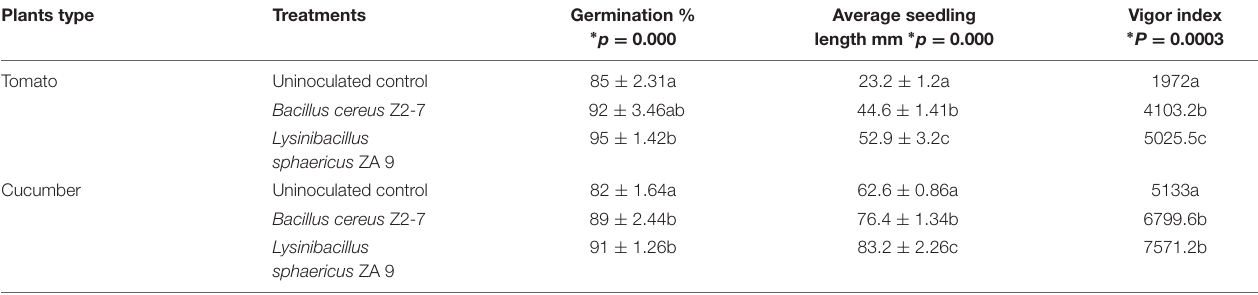
TABLE 1B | Effect of L. sphaericus ZA9 on germination percentage and seedling vigor of tomato and cucumber plants. Plants